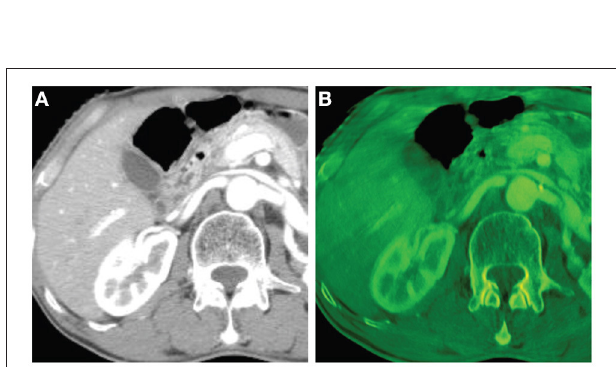
FIGURE 4 | Abdomen images with the display window [ − 280, 320] (Unit: HU). From left, (A) image reconstructed by a Shinva XHCT-16; (B) synthesized color image with components at 40 keV, 50 keV, and 100